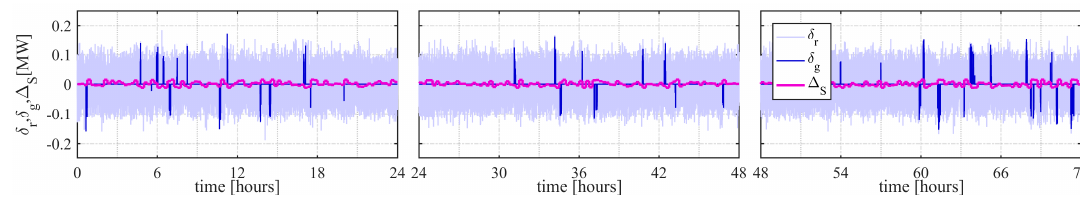
Figure 9. Power fluctuations and forecasting errors on residual power ( δ r , light purple) and grid power ( δ g , blue) achieved by employing the proposed OPEM over three days, together with the S power demand ( Δ S , magenta).